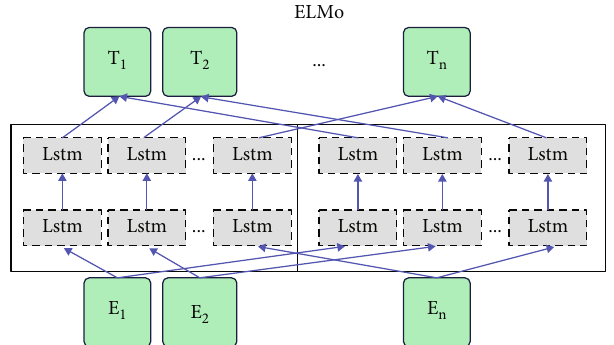
Figure 1: Structure diagram of the ELMo